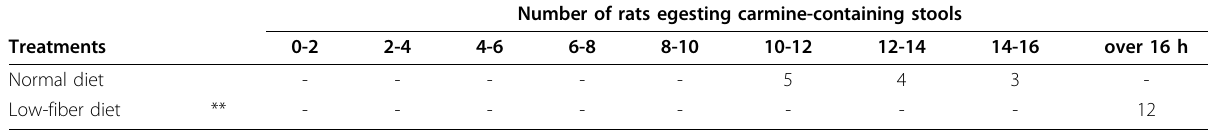
Rats were maintained on a normal-diet or a low-fiber diet for 5 weeks. Carmine (10 mg/body) was orally administered to the rats, then the weights of carmine- containing-stools were measured during consecutive 2-h periods over 16 h. n = 12, **p < 0.01 vs. normal-diet (Chi-square